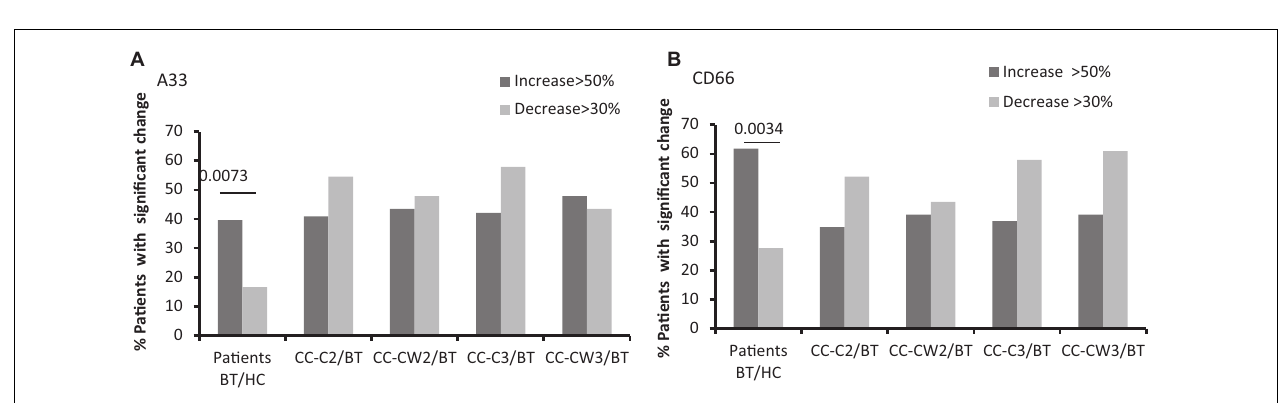
FIGURE 2 | EVs size distribution, concentration and exosome markers. EVs were obtained from the study groups: healthy controls (HC) and colon cancer patients during adjuvant chemotherapy only CC-C or adjuvant chemotherapy with WGJ (CC-W). Samples obtained before treatment (BT, time point 1), during treatment (time point 2) and at the end of treatment (time point 3). EVs were isolated by a series of centrifugations Nanoparticle-tracking analysis-determined EV size distribution (A) and concentration (B) . N = 5 for each study group. WB analysis with antibodies against exosome markers CD63 and CD81. Representative gel with molecular weight marker (MWM) and representative sample of each study cohort (C) graph summaries the bends area divided with protein concentration of each sample that were loaded to the gel. N = 3 (D) .